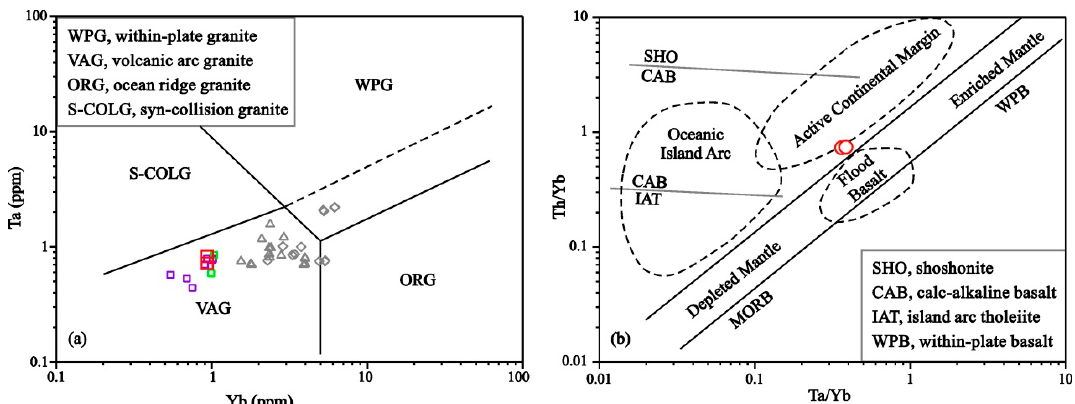
Figure 8. Plots of Sr/Y versus Y ( a ) and La N /Yb N versus Yb N ( b ) for the granodiorites and NEBs from the Xiaozhenzhu Seamount near the Zhongnan Fault in the SCS. Also shown are the data of Mesozoic arc and adakitic granitoids from the SCS [23,24]. The fields of adakite and Archean TTG, and of normal arc andesite and dacite are from [56] and [57], respectively. The symbols are as in Figure 6.